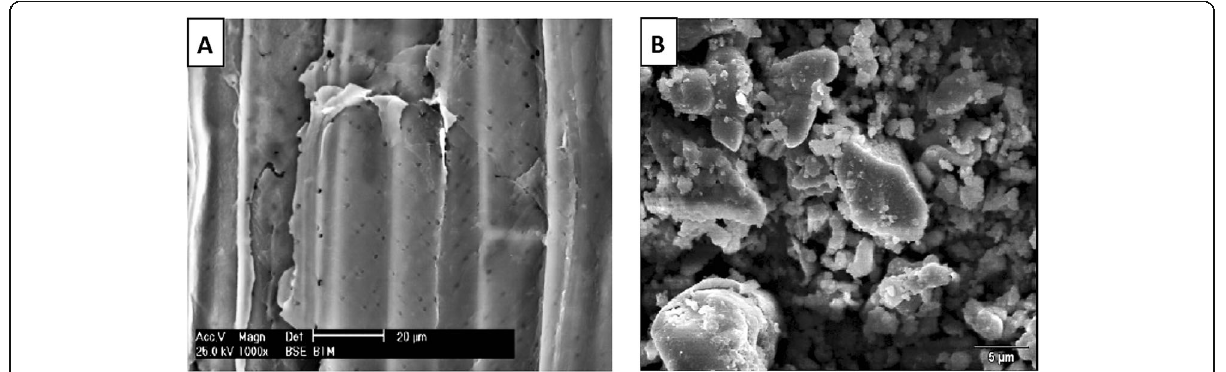
Fig. 1 Morphological structure of SB ( a ) and CC ( b ), adapted from Ref.